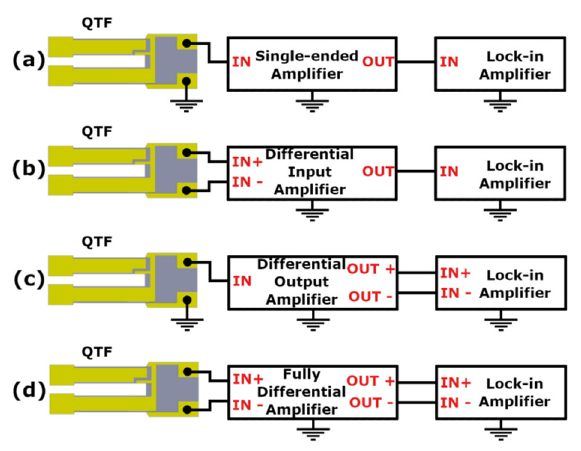
Figure 1. Schematic of the quartz tuning fork (QTF)/front-end amplifier/lock-in connection for four input/output amplifier configurations: ( a ) single-ended, ( b ) differential input, ( c ) differential output and ( d ) fully differential.